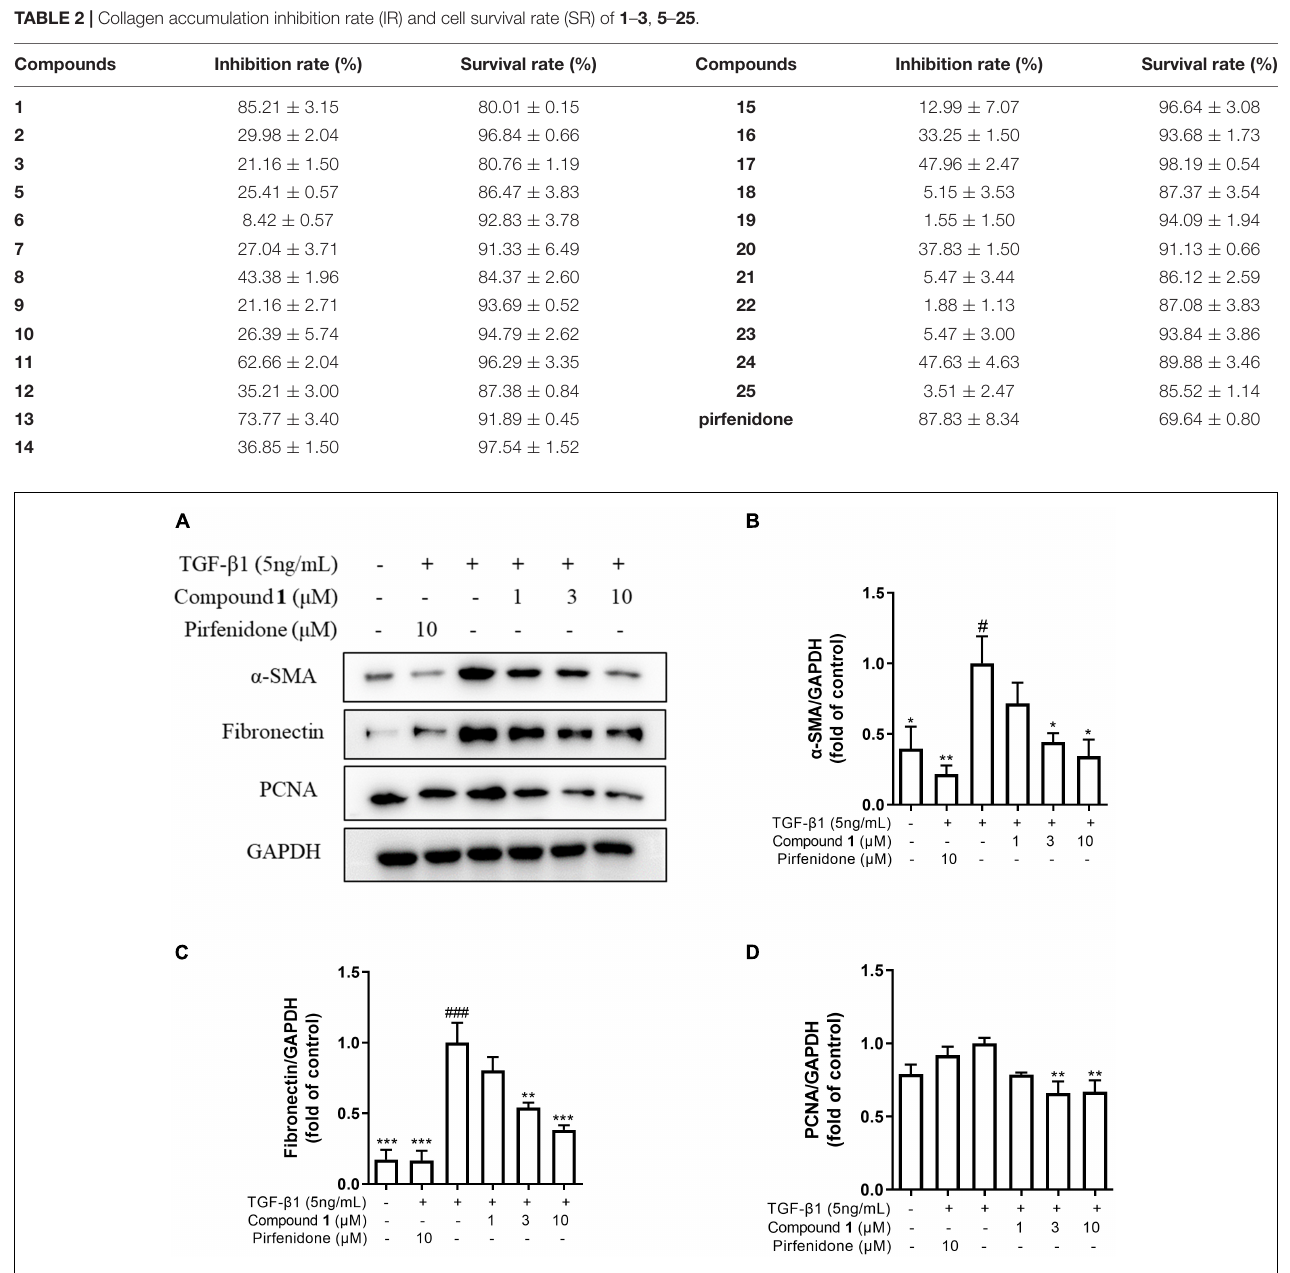
FIGURE 4 | Trichocarboline A ( 1 ) inhibited extracellular matrix (ECM) deposition induced by transforming growth factor (TGF)- β 1 in HFL1 cells. (A–D) HFL1 cells were treated with various concentrations of compound 1 (0, 1, 3, 10 µ M) or pirfenidone in the presence or absence of TGF- β 1 (5 ng/mL) stimulation for 48 h. The protein expression of (B) alpha smooth muscle actin ( α -SMA), (C) fibronectin (FN), and (D) proliferating cell nuclear antigen (PCNA) was analyzed by Western blot. n = 3. Data were presented as the mean ± SEM. * P < 0.05, ** P < 0.01, *** P < 0.001 vs. the TGF- β 1 group. # P < 0.05, ## P < 0.01, ### P < 0.001 vs. the control